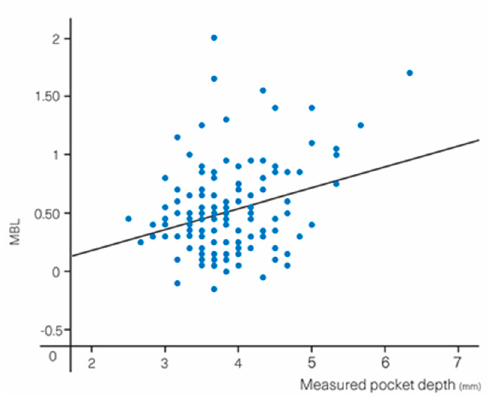
Figure 5. MBL vs. measured pocket depth.